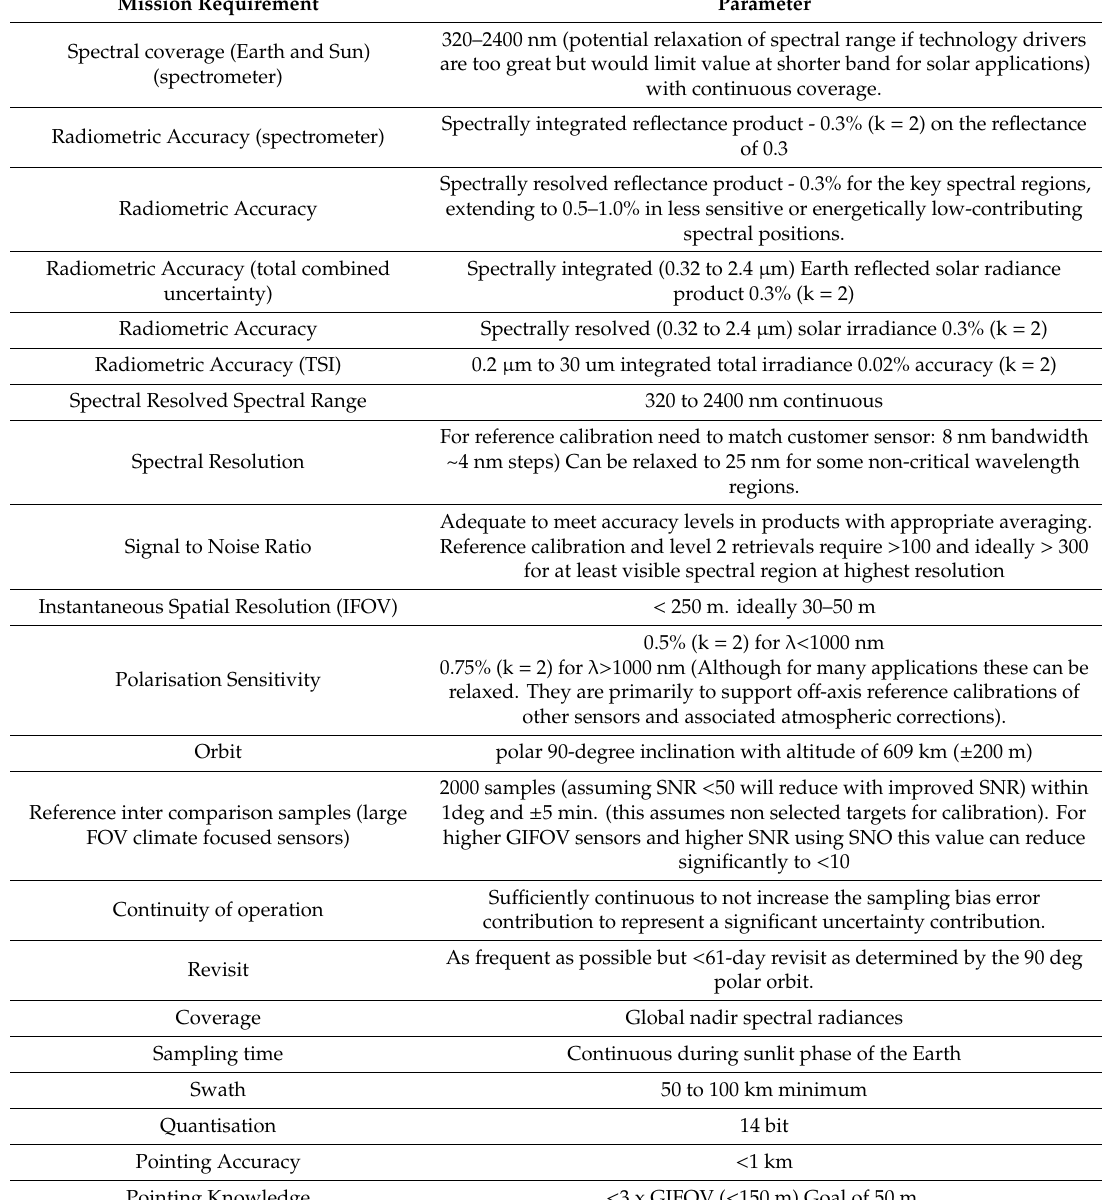
Table 7. TRUTHS mission